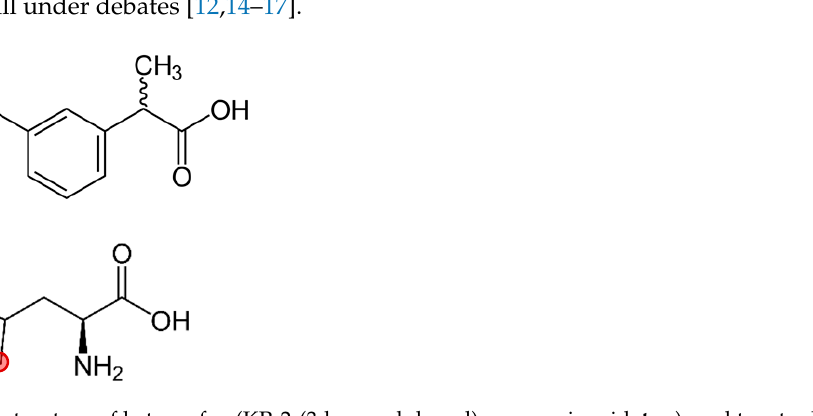
Figure 1. The structure of ketoprofen (KP, 2-(3-benzoylphenyl) propanoic acid, top), and tryptophan (bottom).